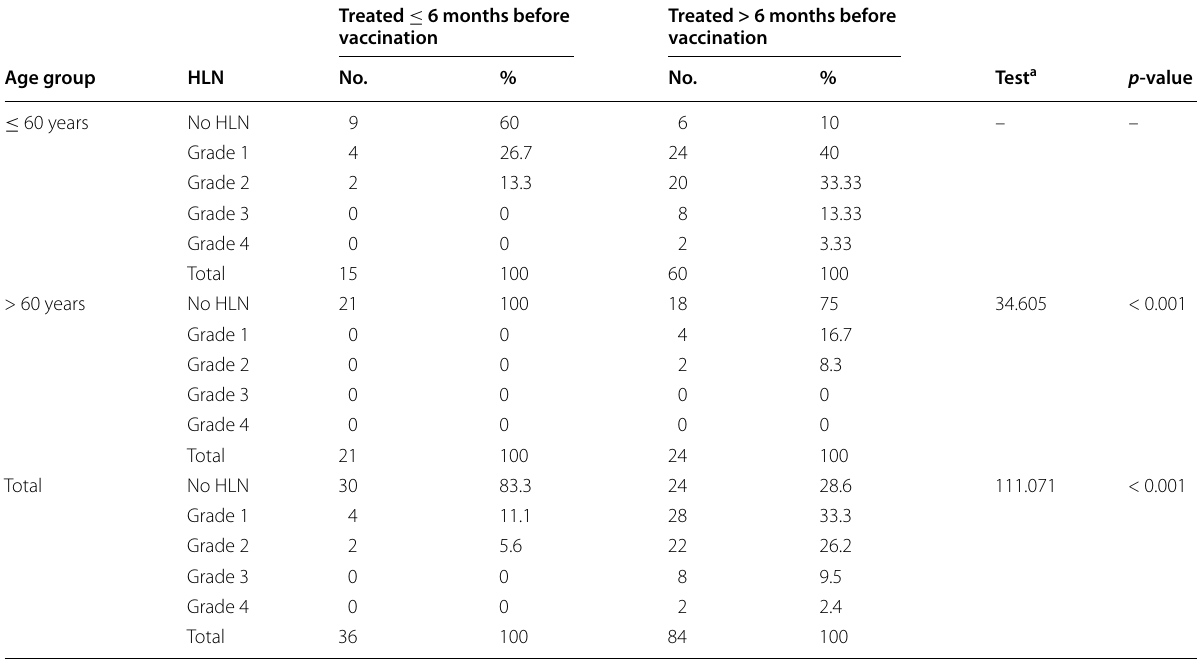
Categorical variables were expressed as number (percentage) a Chi-square test; p < 0.05 is significant Table 4 Relationship between VAHL and serology